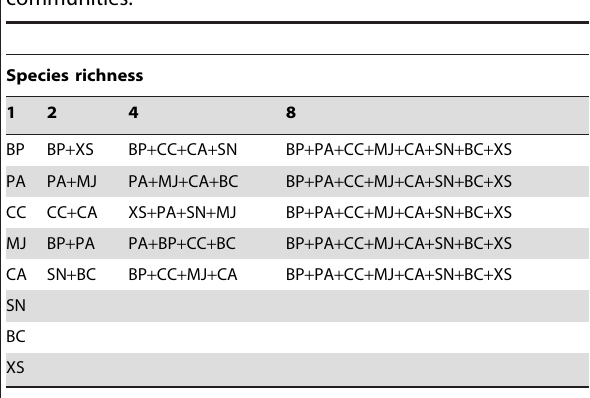
Table 2. The species composition of each pot at the four species richness levels for the experimental plant communities.